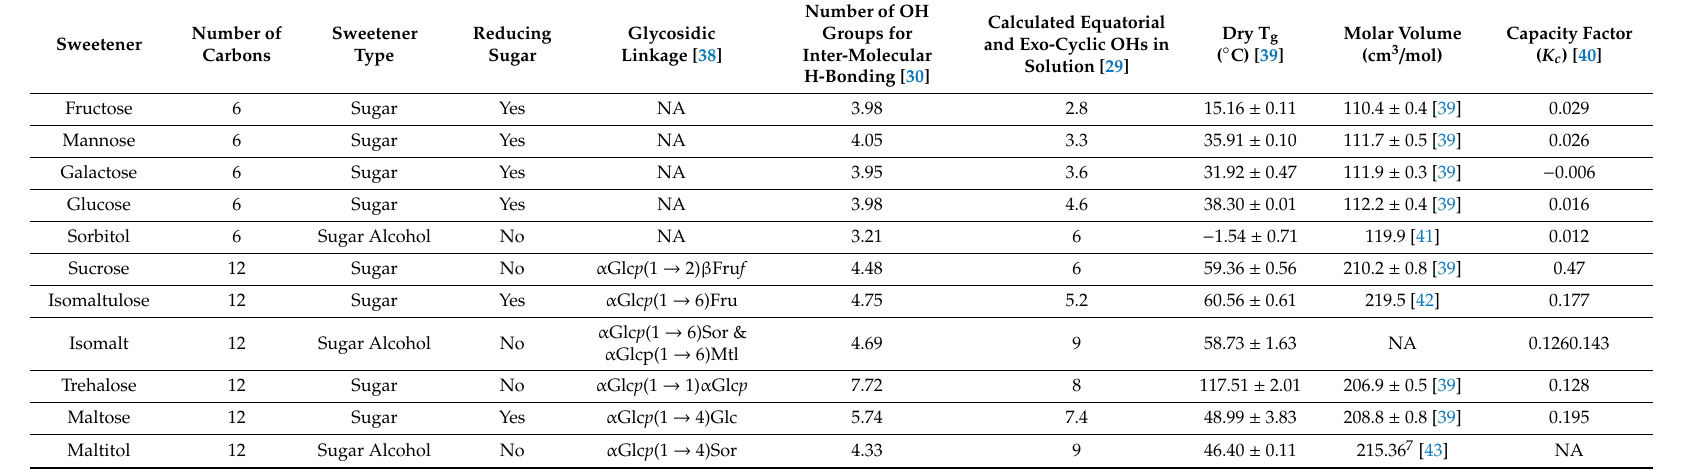
Table 2. Properties of the sweeteners used in this